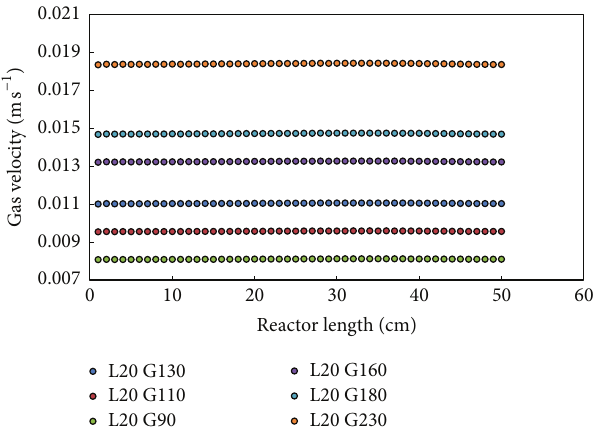
Figure 7: Calculated pressure profiles in the reactor for a liquid flow rate of 20mL min −1 and various gas flow rates.